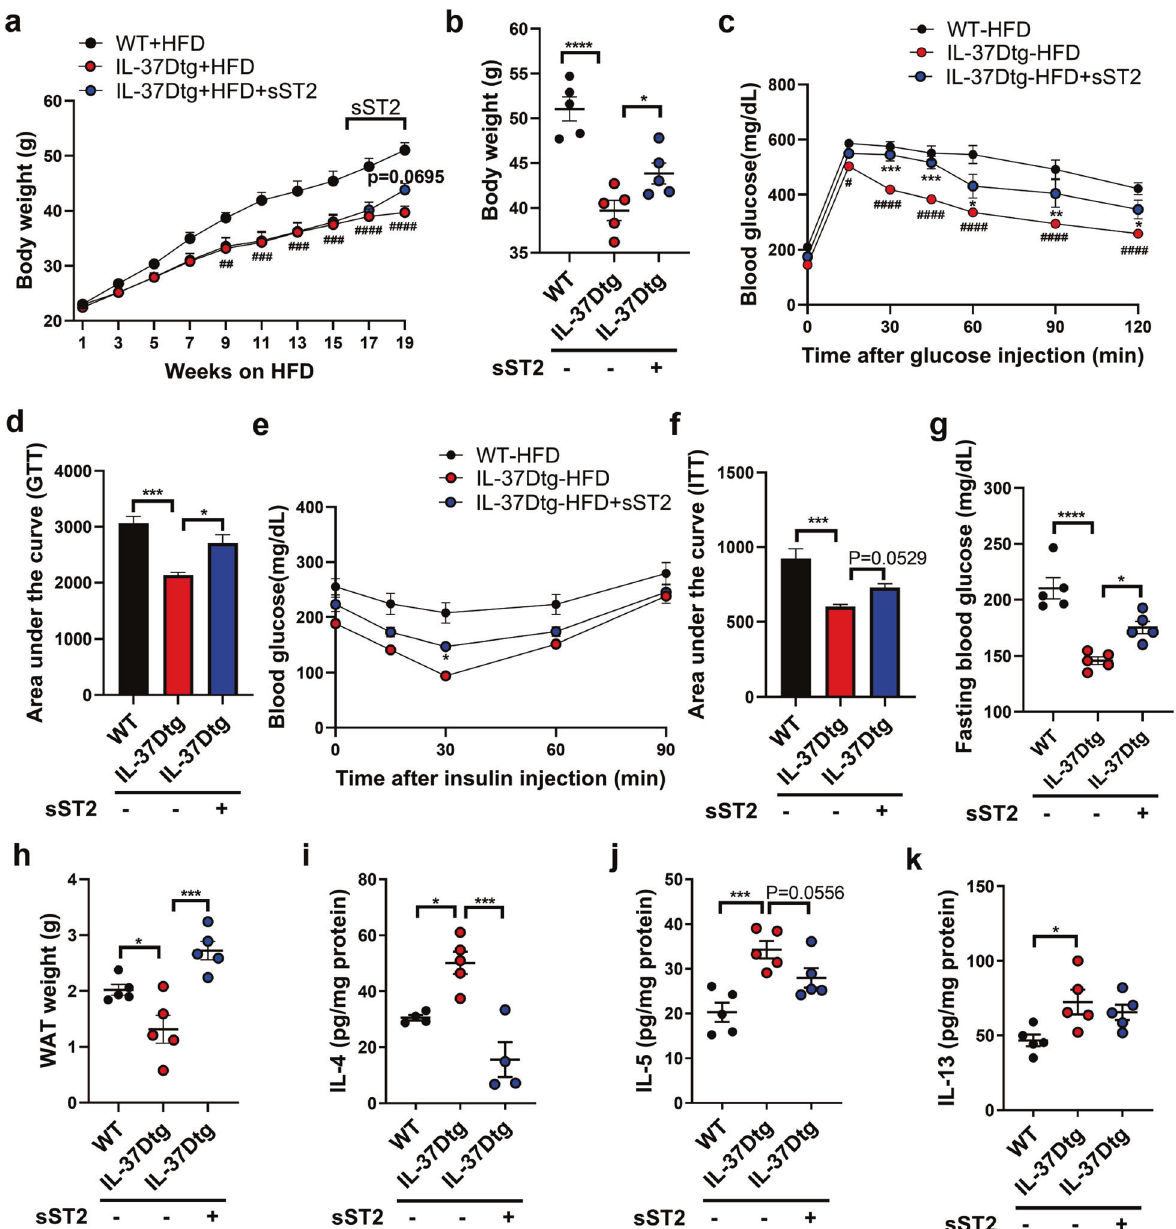
Fig. 5 Recombinant sST2 disrupts the protection of IL-37D against obesity, insulin resistance, and hepatic steatosis in HFD-fed mice. IL- 37Dtg and WT mice were fed on HFD for 19 weeks ( n = 5 per group), recombinant sST2 was intraperitoneally injected into IL-37Dtg mice during the last 3 weeks (2 μ g every 3 days). Body weight was recorded during ( a ) and after ( b ) the intervention. Glucose tolerance test (GTT, c ) and insulin tolerance test (ITT, e ) were performed, respectively, the values of area under the curve in GTT ( d ) and ITT ( f ) were measured. The fasting level of blood glucose was measured ( g ). The weight of inguinal WAT ( h ) was examined and the secretion levels of IL-4 ( i ), IL-5 ( j ), IL-13 ( k ) from its explants were detected by ELISA. Data represent mean ± SEM. * p < 0.05, ** p < 0.01, *** p < 0.001, **** p < 0.0001 determined by two- way ANOVA ( a , c, e ) or one-way ANOVA ( b , d , f – k Srebp1c [36 – 39], the decrease of TNF- α in liver tissues might signaling dependent on IL-1R8 in mouse macrophages [28]. To our relieve hepatic lipogenesis via weakening the role of Srebp1c, interest, IL-1R8 knockdown in IL-37Dtg ADSCs obviously abolished thereby attenuating the development of fatty liver in HFD-fed IL- the suppression of IL-37D on NF- κ B activation and sST2 37Dtg mice. production, demonstrating that IL-37D functions in an IL-1R8- Taken together, this study provides evidence for the potential of depnednent manner to inhibit NF- κ B activation and sST2 human IL-37D to promote type 2 immune homeostasis in WAT by expression. In addition, NF- κ B inhibition together with decreases suppressing sST2, which is characterized by the ampli fi cation of in TNF- α and Srebp1c expression were also detected in liver ST2 + immune cells, M2 macrophage polarization, and type 2 tissues from HFD-fed IL-37Dtg mice compared with those from HFD-fed WT mice (Fig. S6a – c). Since TNF- α signaling can stimulate cytokines secretion. The maintenance of type 2 response hepatic lipogenesis via promoting the expression or activation of contributes to in fl ammation resolution and beiging in WAT,